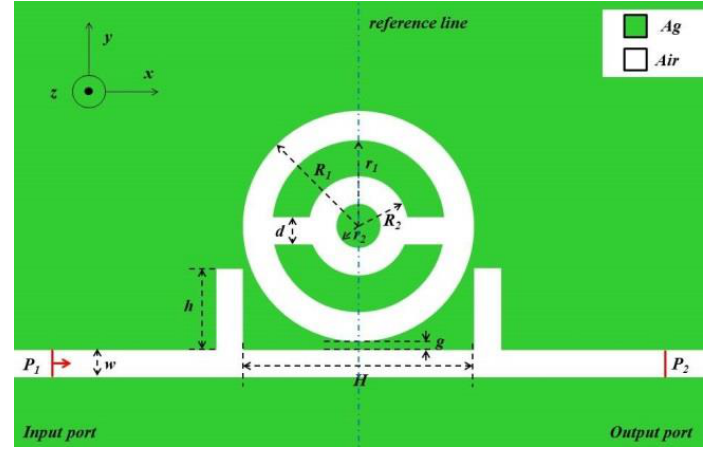
Figure 1. Two-dimensional schematic diagram of a metal−insulator−metal (MIM) waveguide with twin symmetrical rectangle baffles coupled with a connected concentric double rings resonator (CCDRR).